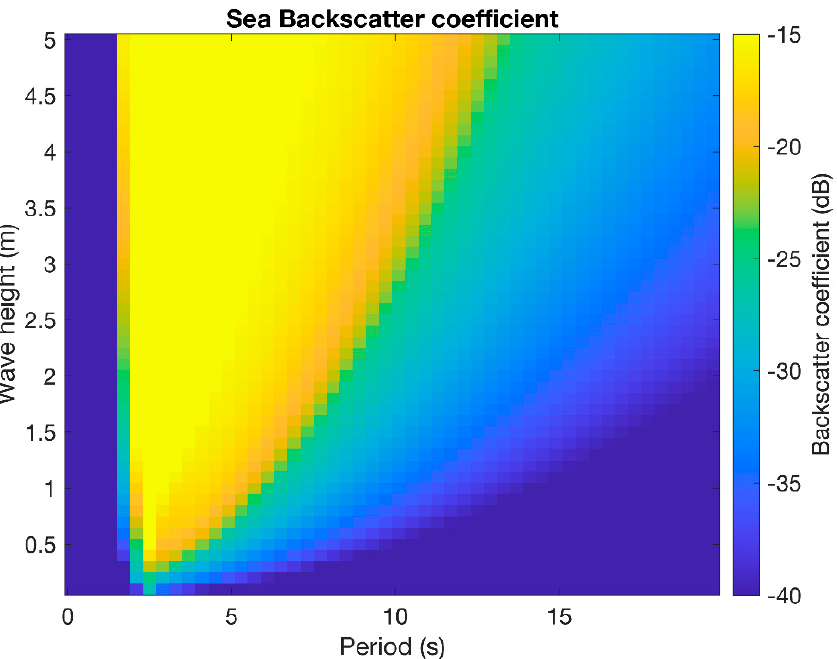
Figure 2. The backscatter coefficient calculated for a range of wave heights and periods using the Barrick method for a radar operating at 15 MHz. The radar beam steer angle and wind were in the same direction. Values much greater than that of a fully developed sea (approximately − 23 dB) are due to a non-physical combination of wave height and wave period.